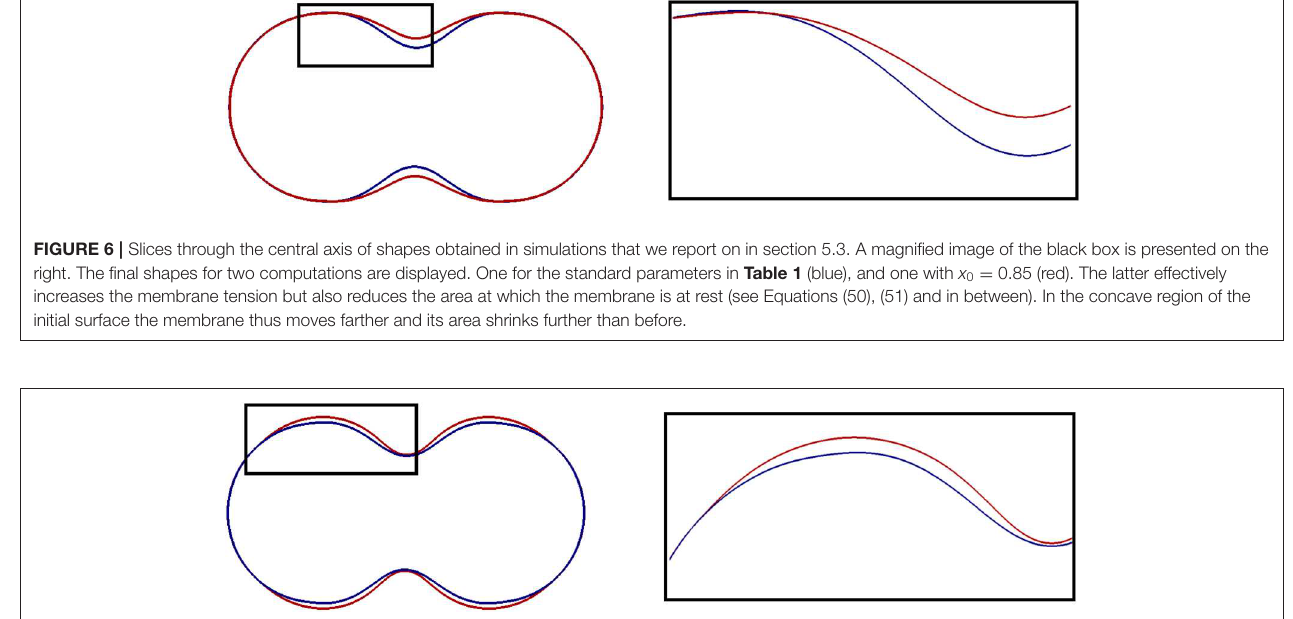
FIGURE 7 | Slices through the central axis of shapes obtained in simulations that we report on in section 5.3. A magnified image of the black box is presented on the right. The final shapes for two computations are displayed. One for the standard parameters in Table 1 (blue), and one with a higher pressure parameter, namely p 0 30 (red). In the latter case, the cell membrane is further pushed outside, and the area where the membrane has detached from the cortex is wider. =